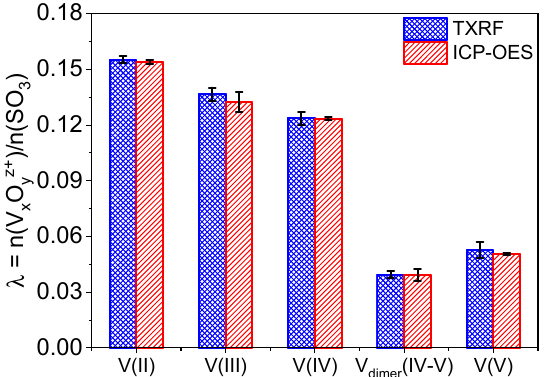
Figure 3. Uptake of V(II), V(III), V(IV), V dimer (IV–V), and V(V) (1.6 M in all cases) in Nafion™ using TXRF and ICP-OES (n = 6).